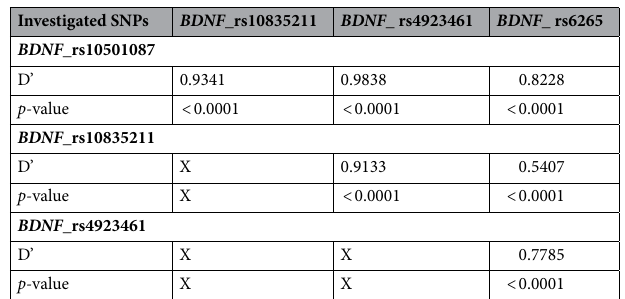
Table 1. The results of linkage disequilibrium